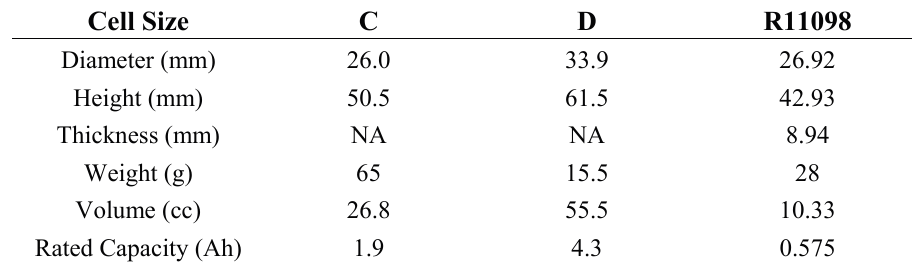
Table 1. Types of batteries for biomedical devices (based on [51]).